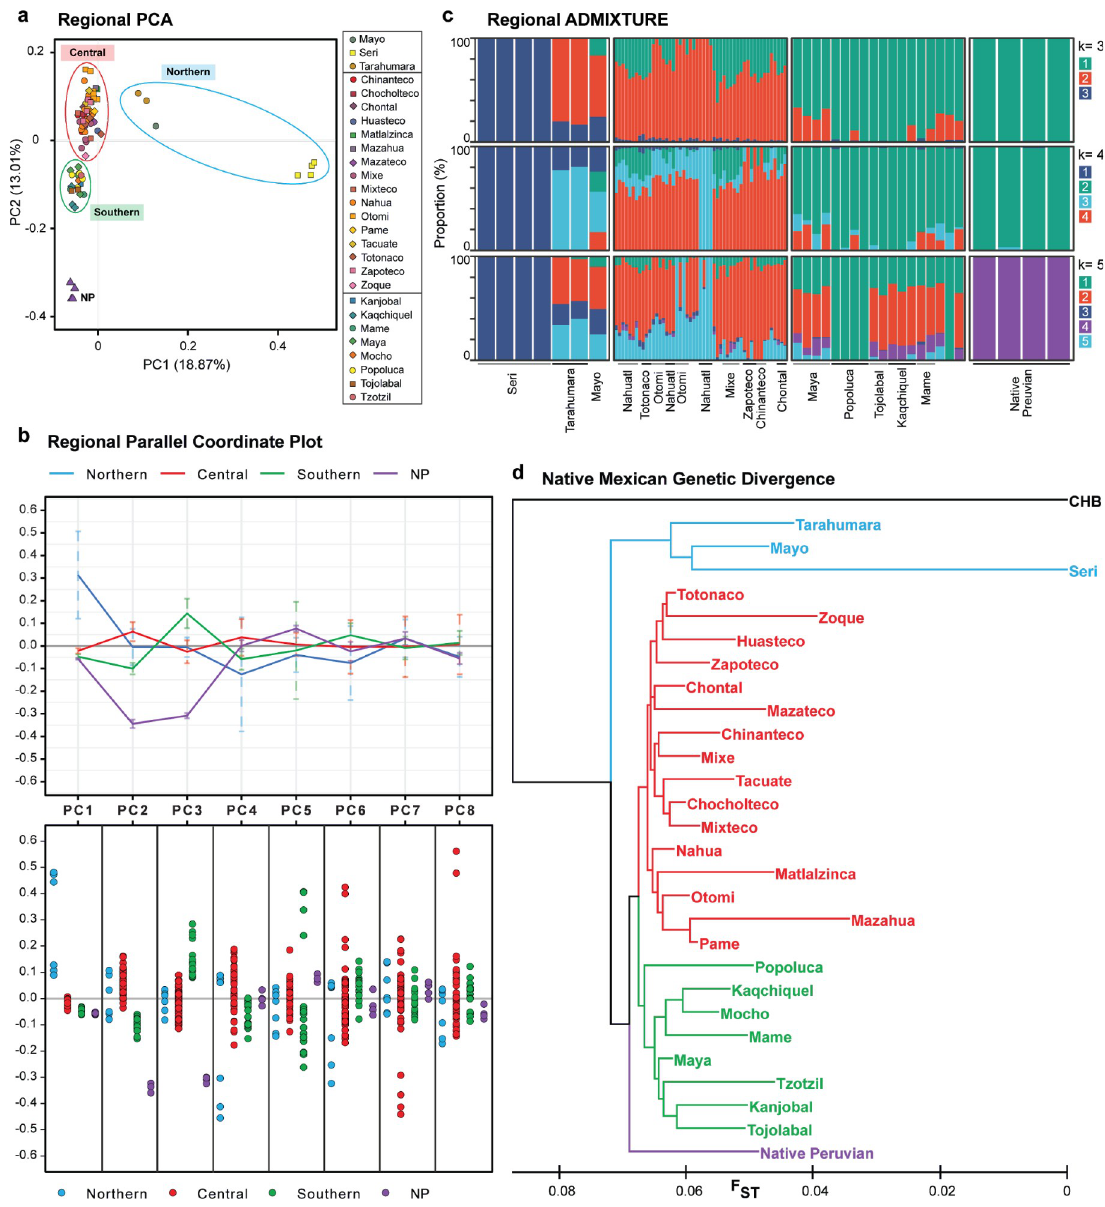
Fig 4. NM demography. (a) PCA of NM including 4 Native Peruvians (NP). (b) Summarized Parallel Coordinate Plot, showing only statistically significant PCs; (b) top panel, PC values per region, solid lines depict mean values, and dashed lines depict standard deviation; (b) bottom panel, dotted parallel coordinate plot, each dot depicts an individual. (c) ADMIXTURE analysis for different k, samples are ordered by geographic latitude and ethnic group. (d) Neighbor-joining tree based on F ST between the 27 NM groups and NP in our study; colors indicate Region from Fig